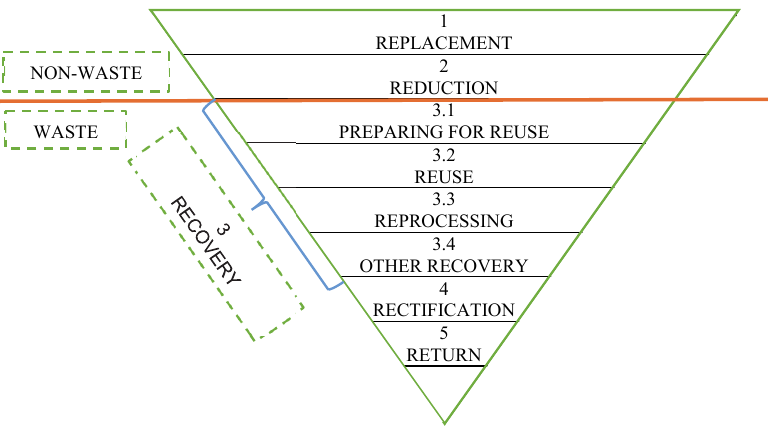
Fig. 1. Waste Utilization Priority Triangle (Source:Gharfalkar et